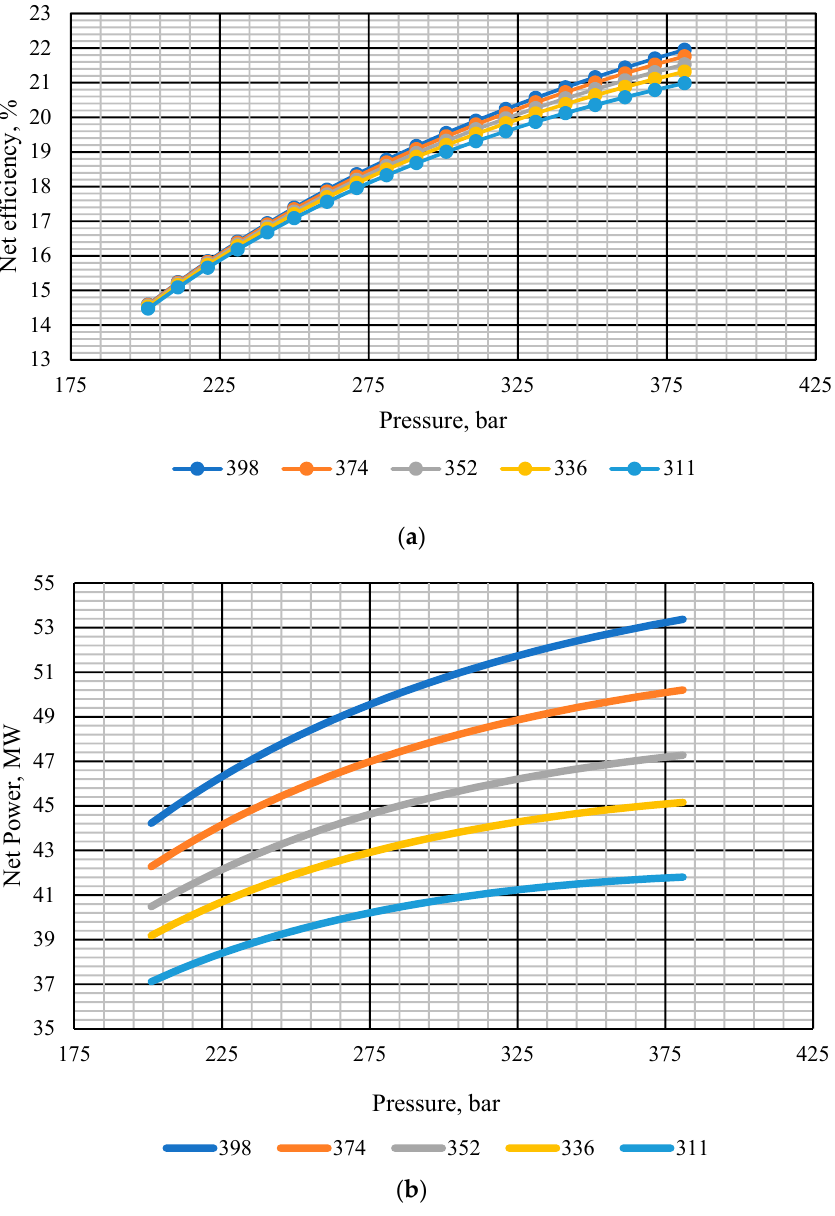
Figure 10. Investigation of the influence of pressure changes at the inlet to a carbon dioxide turbine. ( a ) Net efficiency. ( b ) Net power.